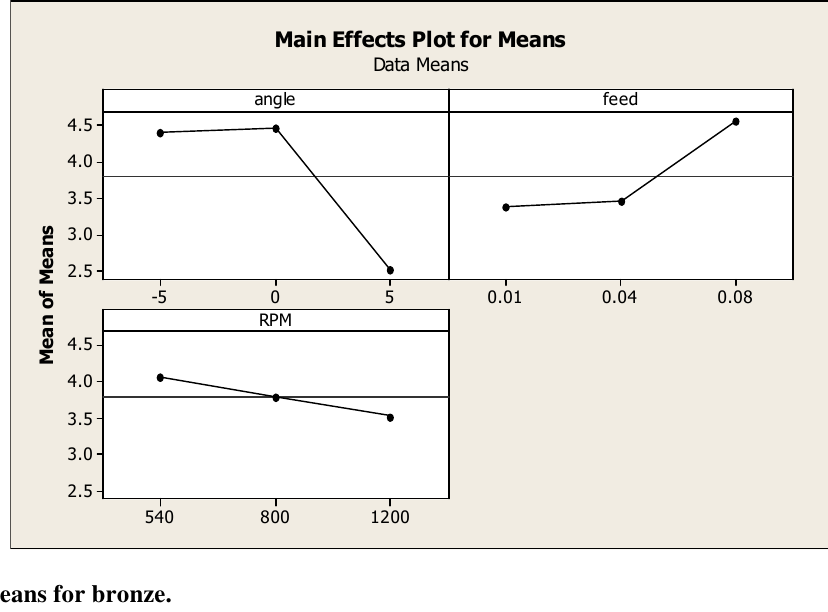
Fig. 6. Plot for means for bronze.